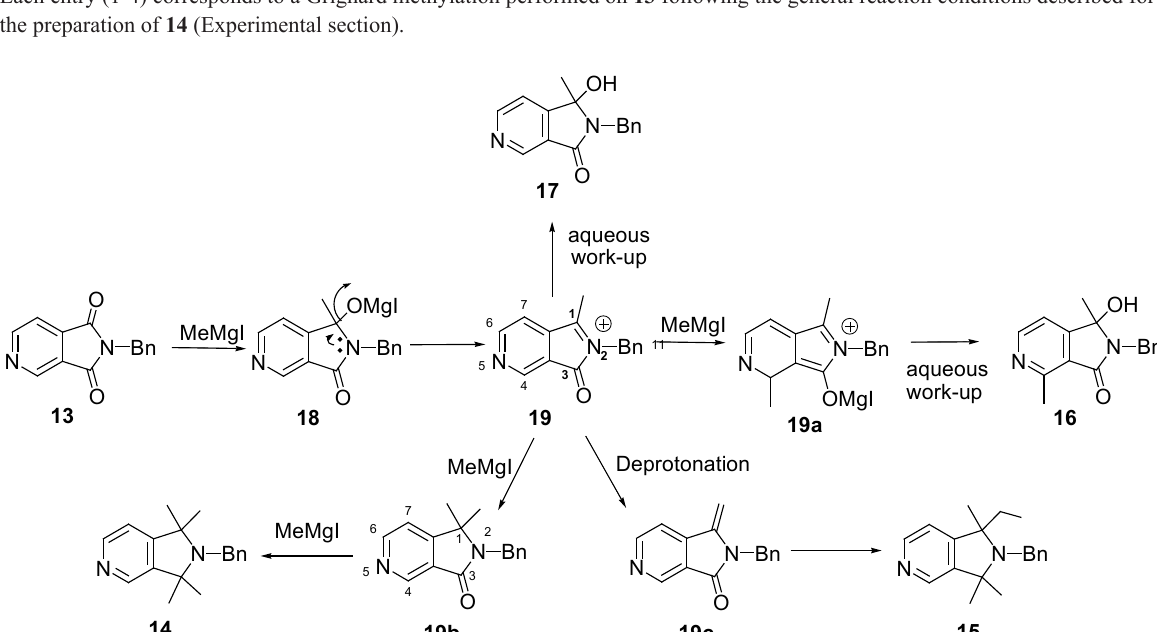
Table 1: HPLC product ratios obtained from the reaction of imide 13 with excess MeMgI. Entry Equiv. Equiv. Reaction HPLC product ratio (%) 14 15 16 17 Mg MeI time (h) 1 8.0 6.0 3 - - 43 57 2 8.0 6.0 5 22 10 27 41 3 8.0 6.0 24 3 19 30 48 4 10.0 8.0 72 23 14 31 32